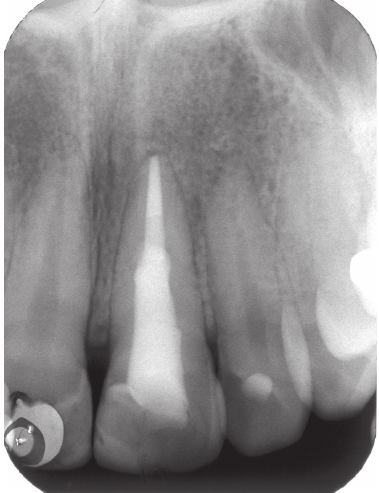
Figure 15: Radiograph at 2 years.